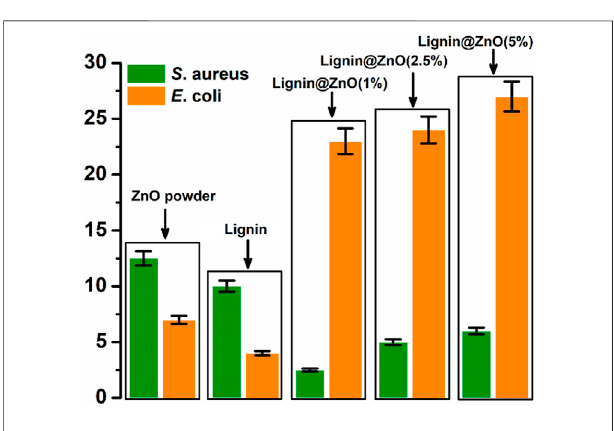
FIGURE 8 | Zone of inhibition exhibited by the ZnO powder, Lignin, and 1, 2.5, and 5% Lignin@ZnO-GTR membrane against S . aureus , and E. coli